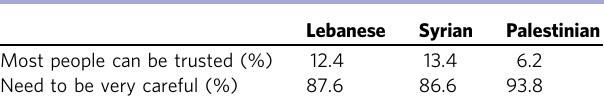
Table 4 General trust by